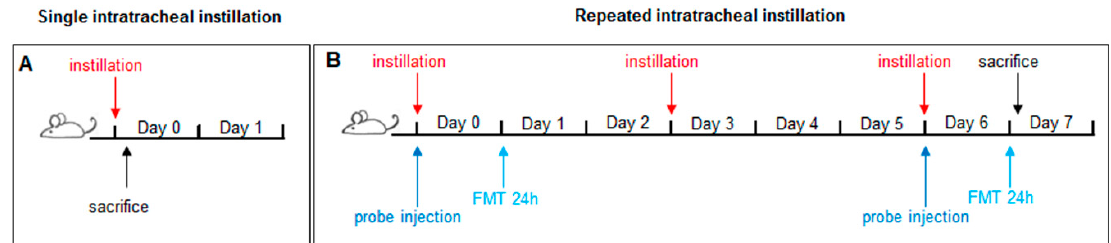
Figure 9. Schematic representation of BALB / c acute ( A ) and sub-acute ( B ) treatment and FMT.